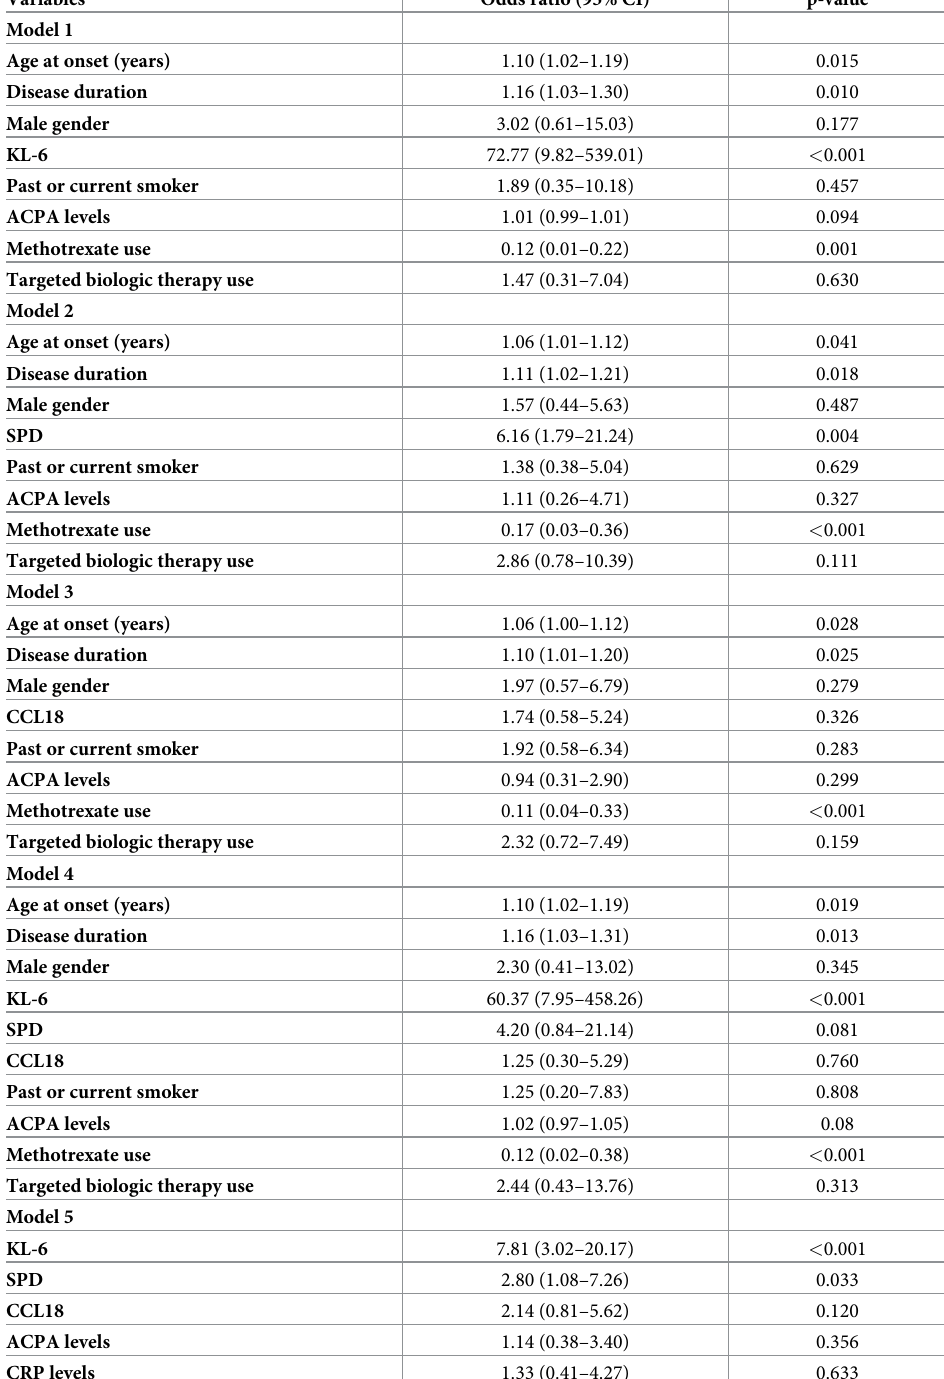
Table 3. Multivariate logistic regression analysis including RA-ILD as the dependent variable and RA-ILD risk factors as covariates.